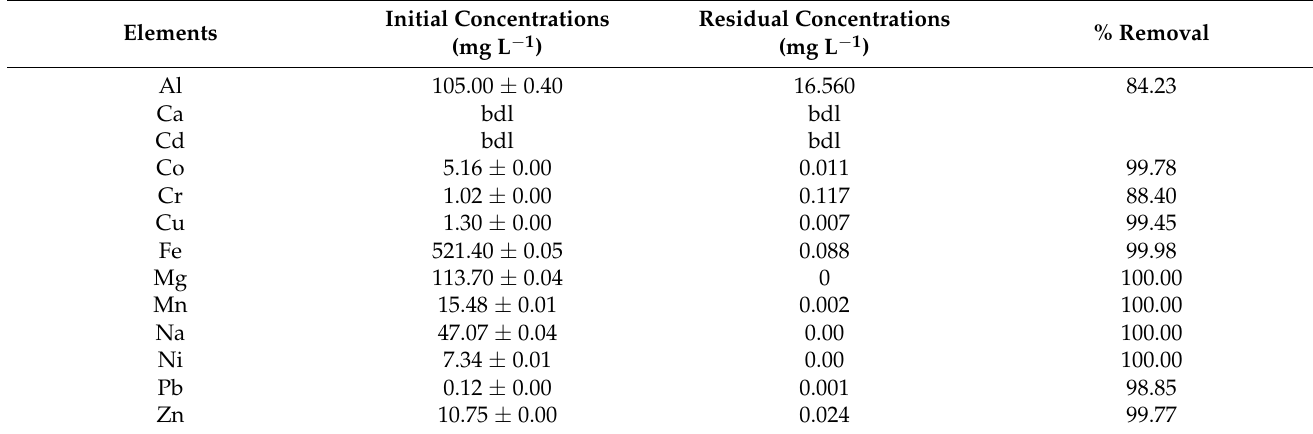
Table 5. Sampling site RTW2.